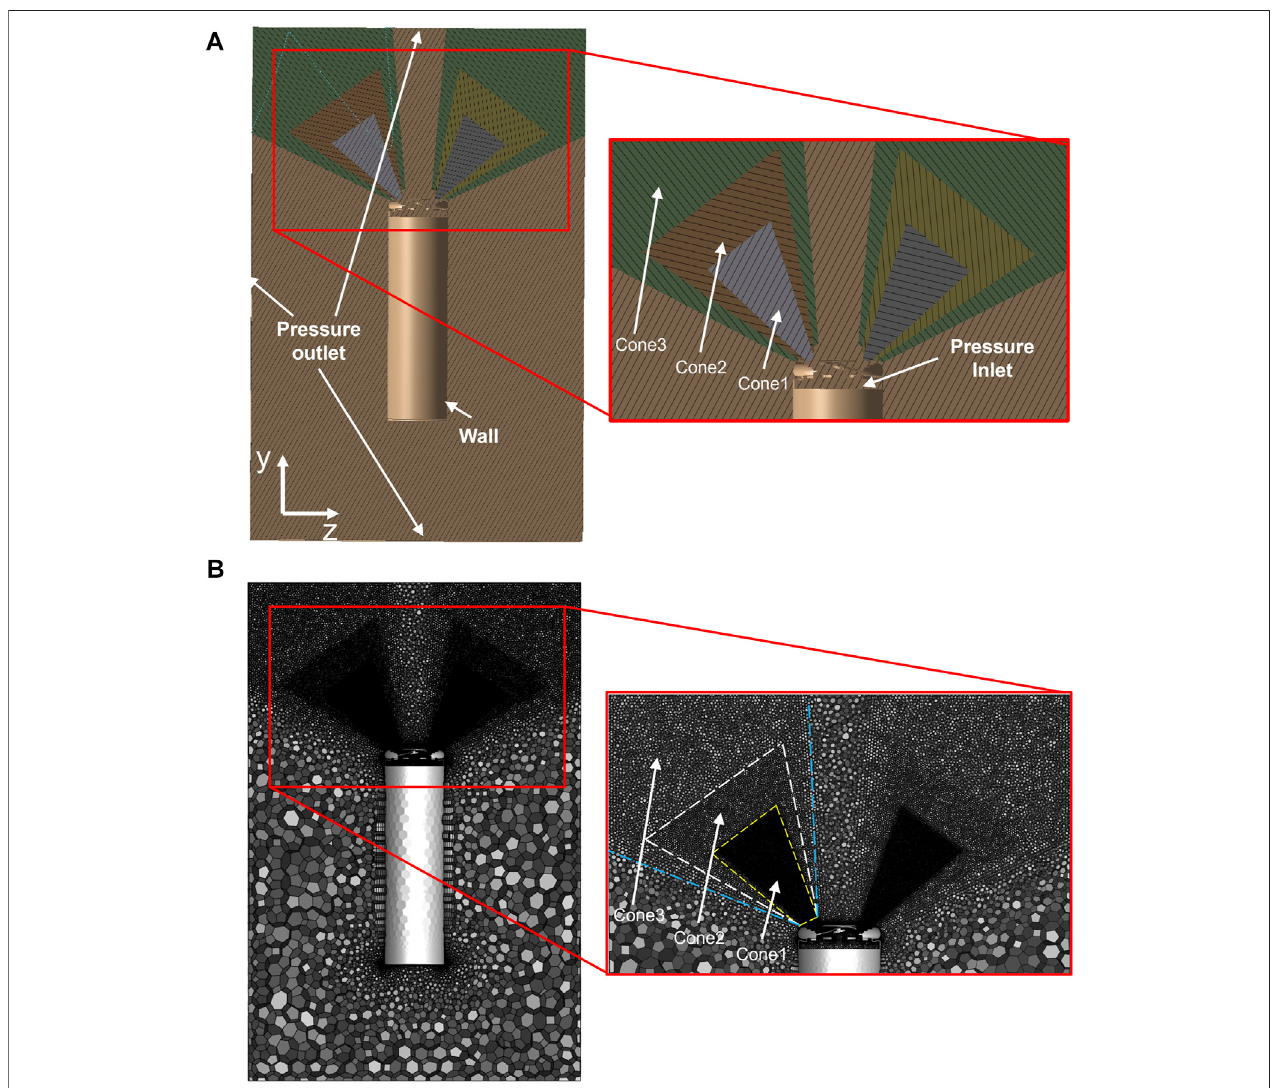
FIGURE 3 | Cross-sectional view showing the geometry (A) and mesh (B) of computational domain and boundary conditions for SRS simulations of fl ow through the LG MJ1 cap.